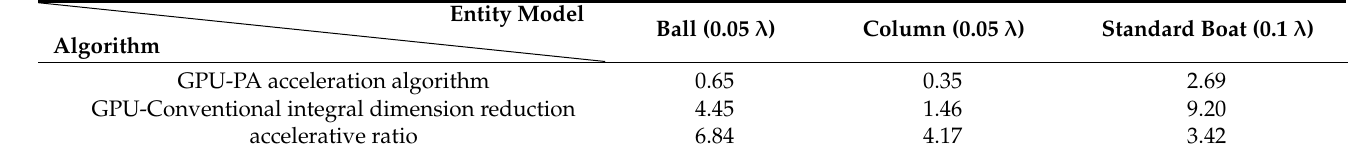
Table 2. Comparison of the calculation time (unit: